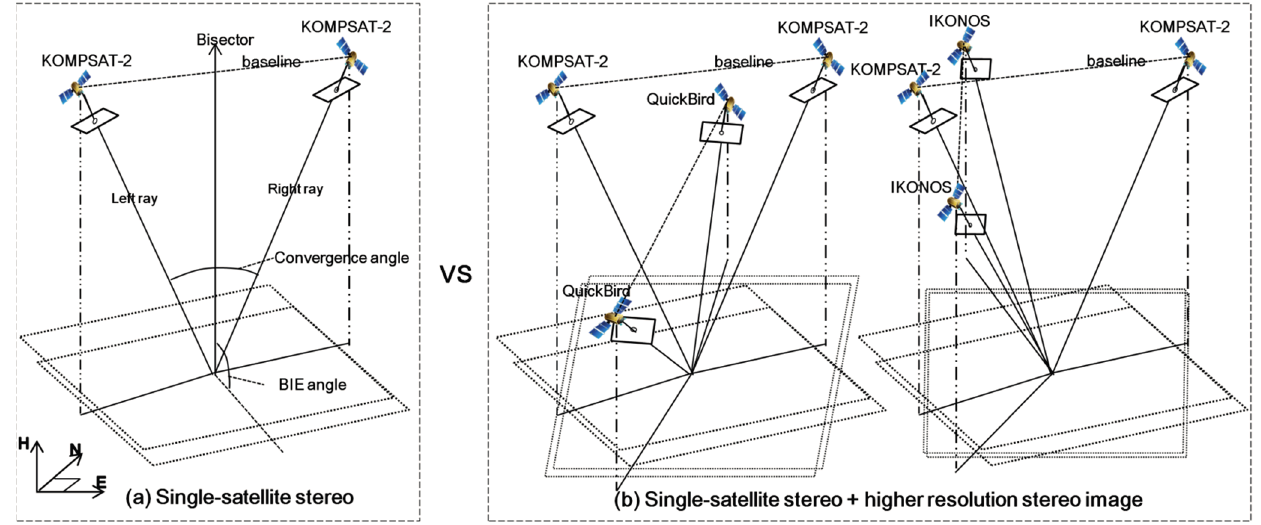
Figure 5. Test cases for comparison before and after the integration of higher resolution stereo image. ( a ) single-satellite stereo, ( b ) single-satellite stereo + higher resolution stereo image.